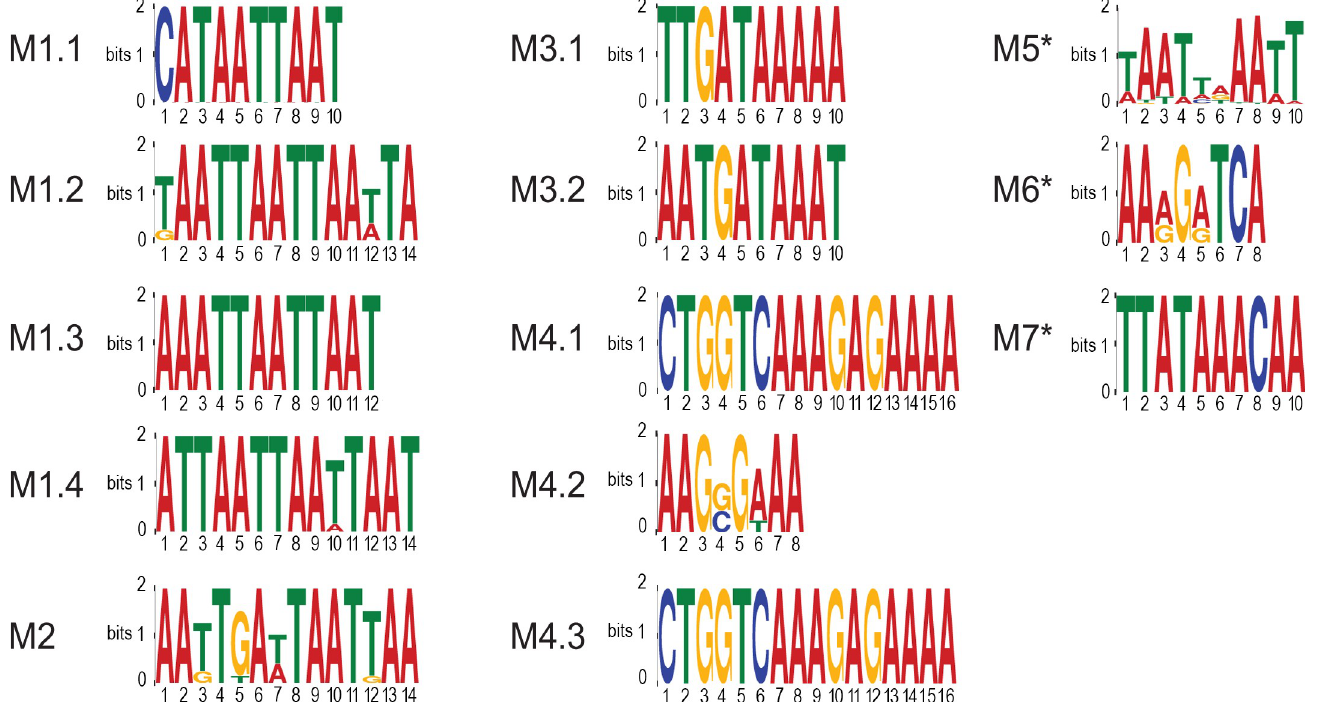
Fig 3. Logos of enriched promoter motifs over the L3 to L4 molt. Motifs found to be enriched (p-value < 10 − 3 ) in the upstream elements of up-regulated genes between different stages of molting and to be conserved in either C . elegans or O . volvulus . The � denotes the three motifs that have been validated experimentally. Note that M7 was included in the experimental validation because it passed 4 out of 5 filters, including the foreground coverage filter, the random forest filter, the known motif filter, and the conservation filter. However, it was not included in the 12 reported motifs due to its non-significant p-value.